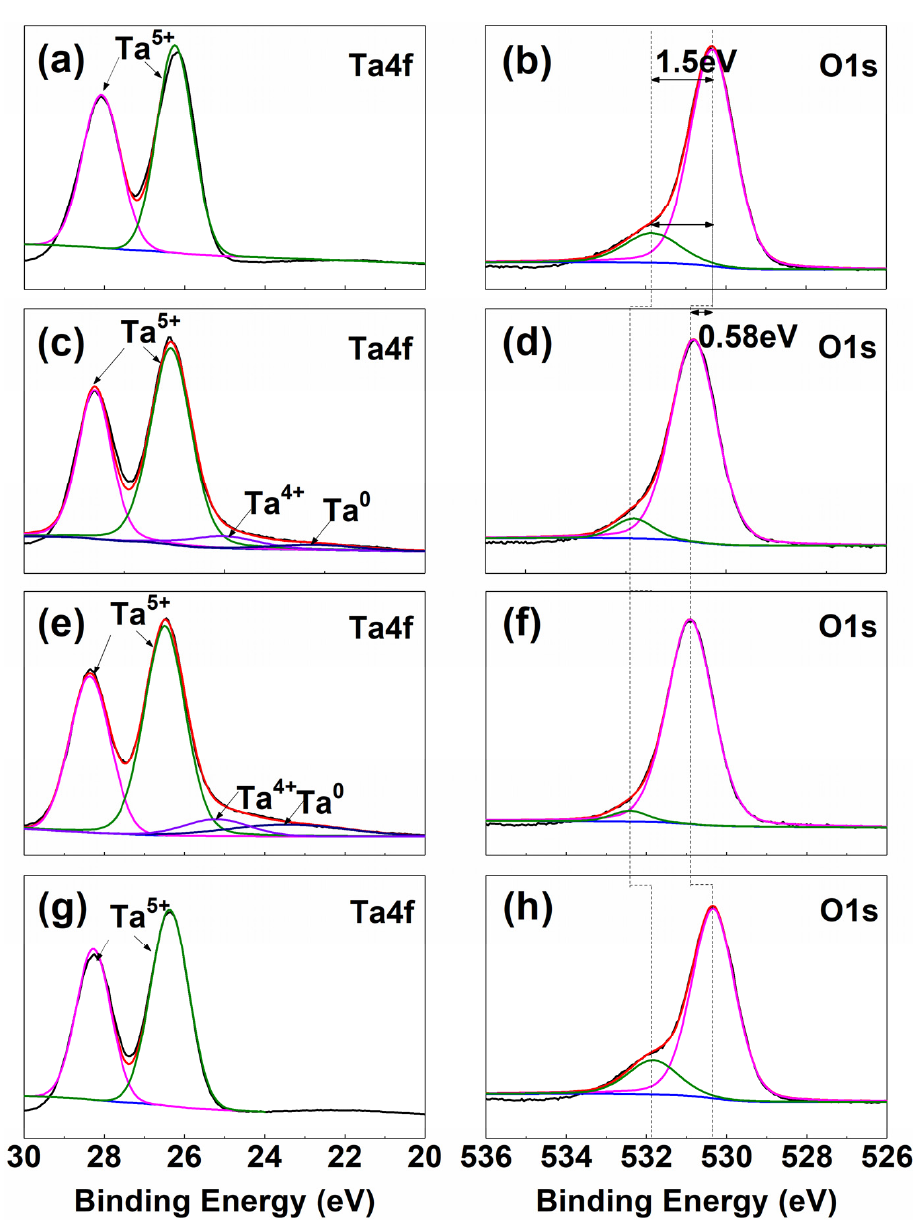
Figure 3. XPS survey spectra of Ta 4f core-level lines for ( a ) VT, ( c ) VT200, ( e ) VT400, and ( g ) VT600. XPS spectra of the Ta 4f and O 1s core-level lines for ( b ) VT, ( d ) VT200, ( f ) VT400, and ( h ) VT600.